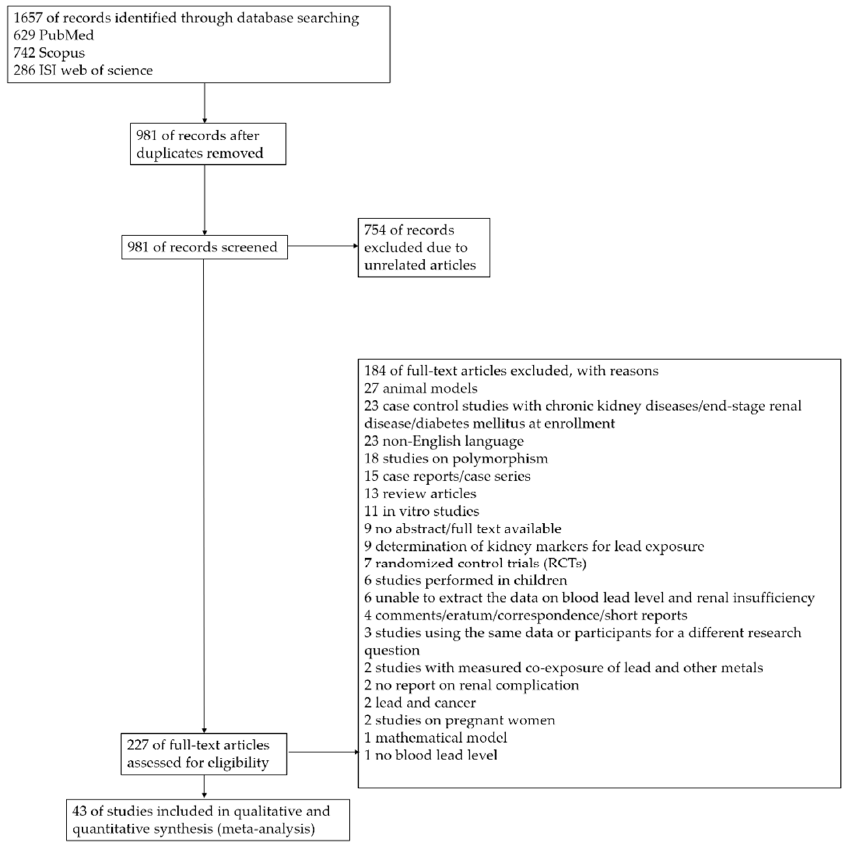
Figure 1. Study flow diagram.